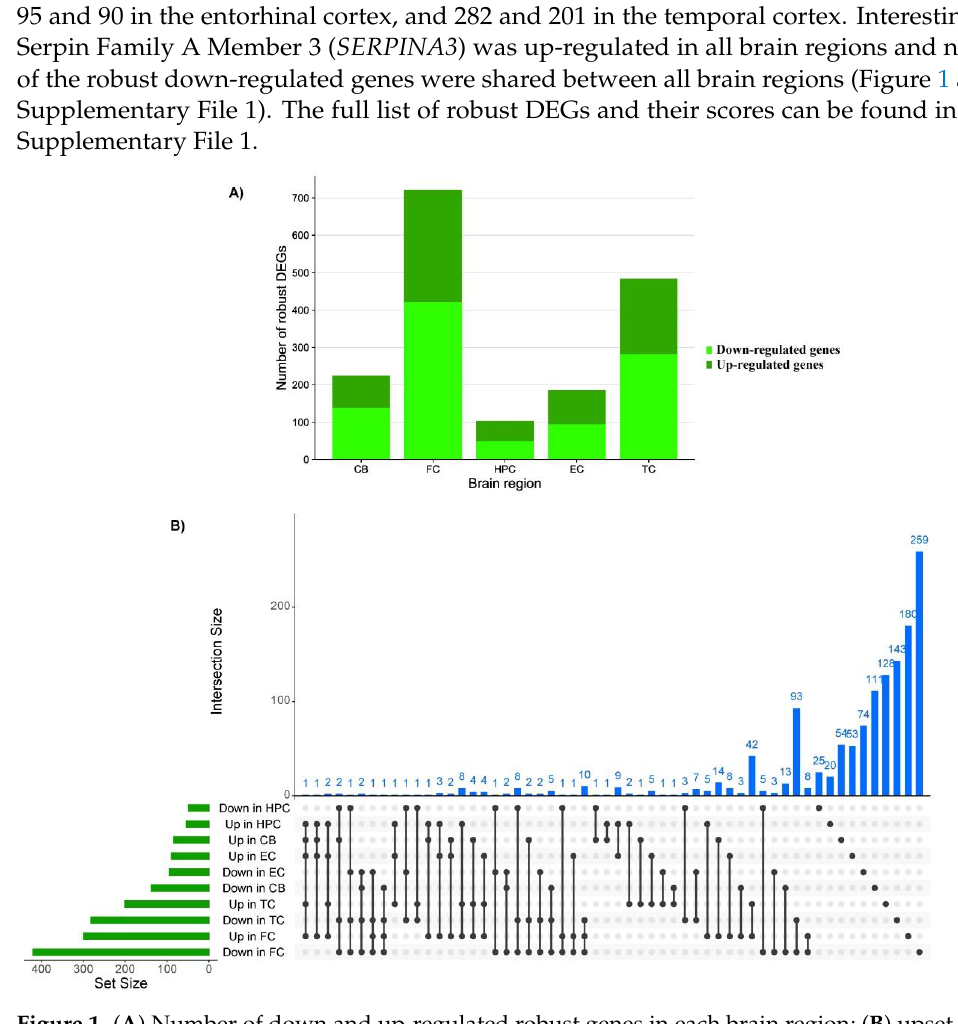
Figure 1. ( A ) Number of down and up-regulated robust genes in each brain region; ( B ) upset plot indicates the overlap of robust differentially expressed genes with either increased or decreased abundance in different brain regions; DEGs, differentially expressed genes; CB, cerebellum; FC, frontal cortex; HPC, hippocampus; EC, entorhinal cortex; TC, temporal cortex. frontal cortex; HPC, hippocampus; EC, entorhinal cortex; TC, temporal